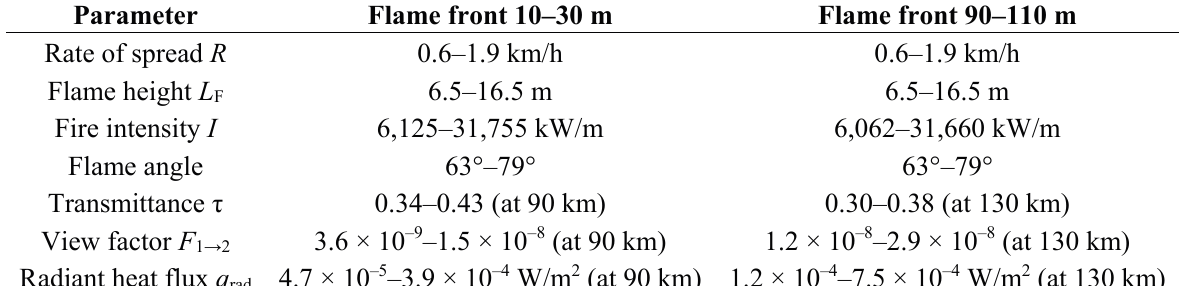
Table 3. Output parameters (5th and 95th percentile) calculated according to the Monte Carlo method with the input parameters from Table 2.